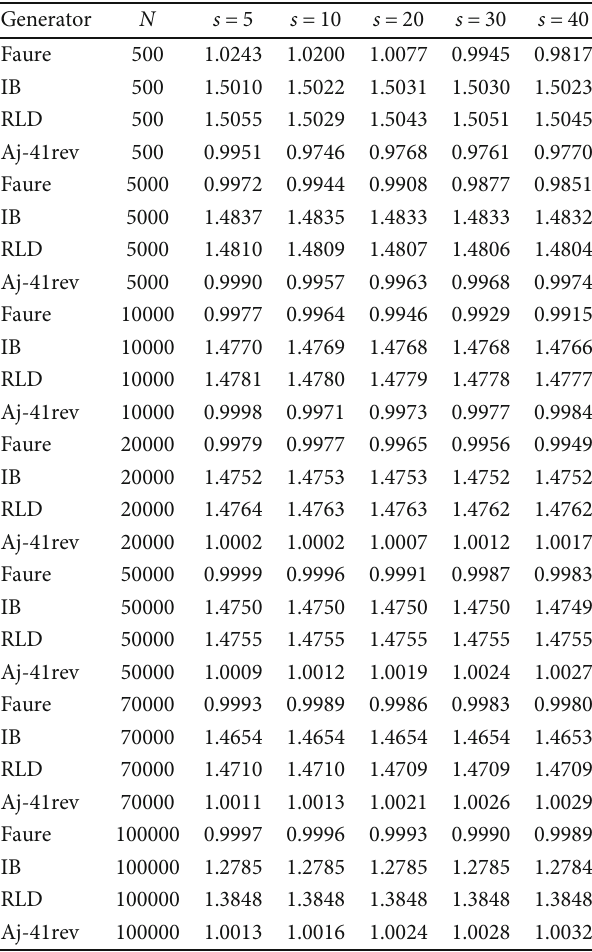
ð f Þ with a = 1 by using Faure sequences. 2 i